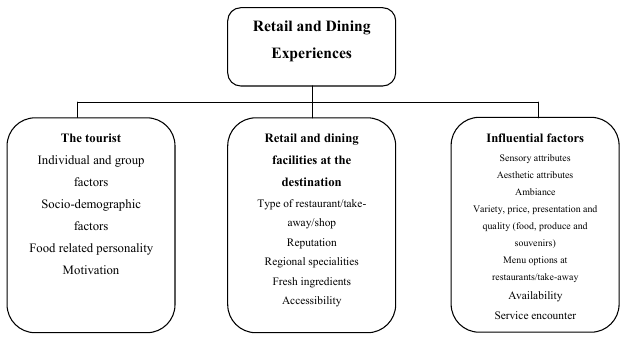
Figure 1: Aspects affecting the travel retail and dining